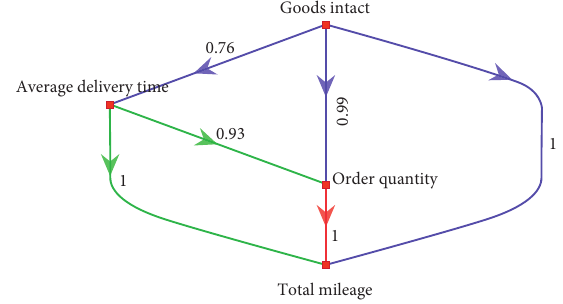
Figure 5: Credal ranking for the “Skills”